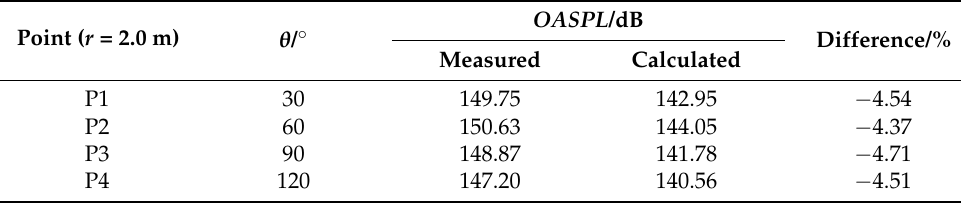
Table 4. Comparison between the calculated and experimental results of OASPL. Point ( r = 2.0 m)